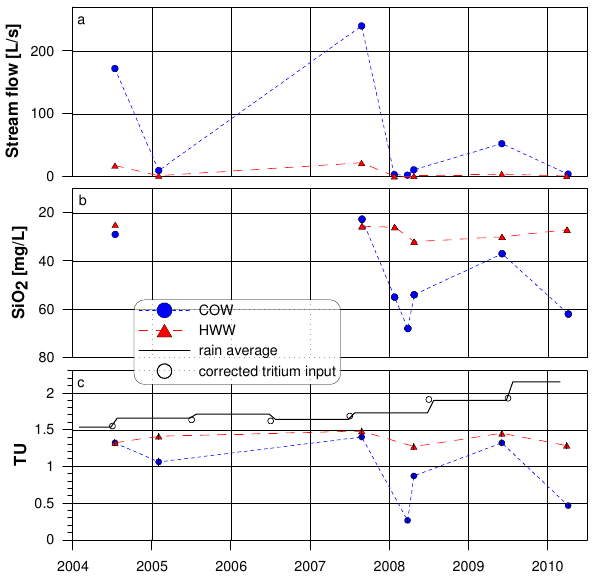
Fig. 5. (a) Streamflow, (b) SiO 2 , and (c) tritium concentration ver- sus time at the catchment outlet weir (COW) and headwater weir (HWW). Note the inverse axis for SiO 2 . Graph c shows, for com- parison, the average tritium concentrations in rain (Kaitoke data scaled by a factor 0.9 to account for the lower latitude at Toenepi, see Fig. 4a), and the corrected annual tritium input. The currently rising tritium concentration in rain is caused by variation in cosmo- genic tritium production, which is modulated by cosmic rays and reflects varying solar activity.